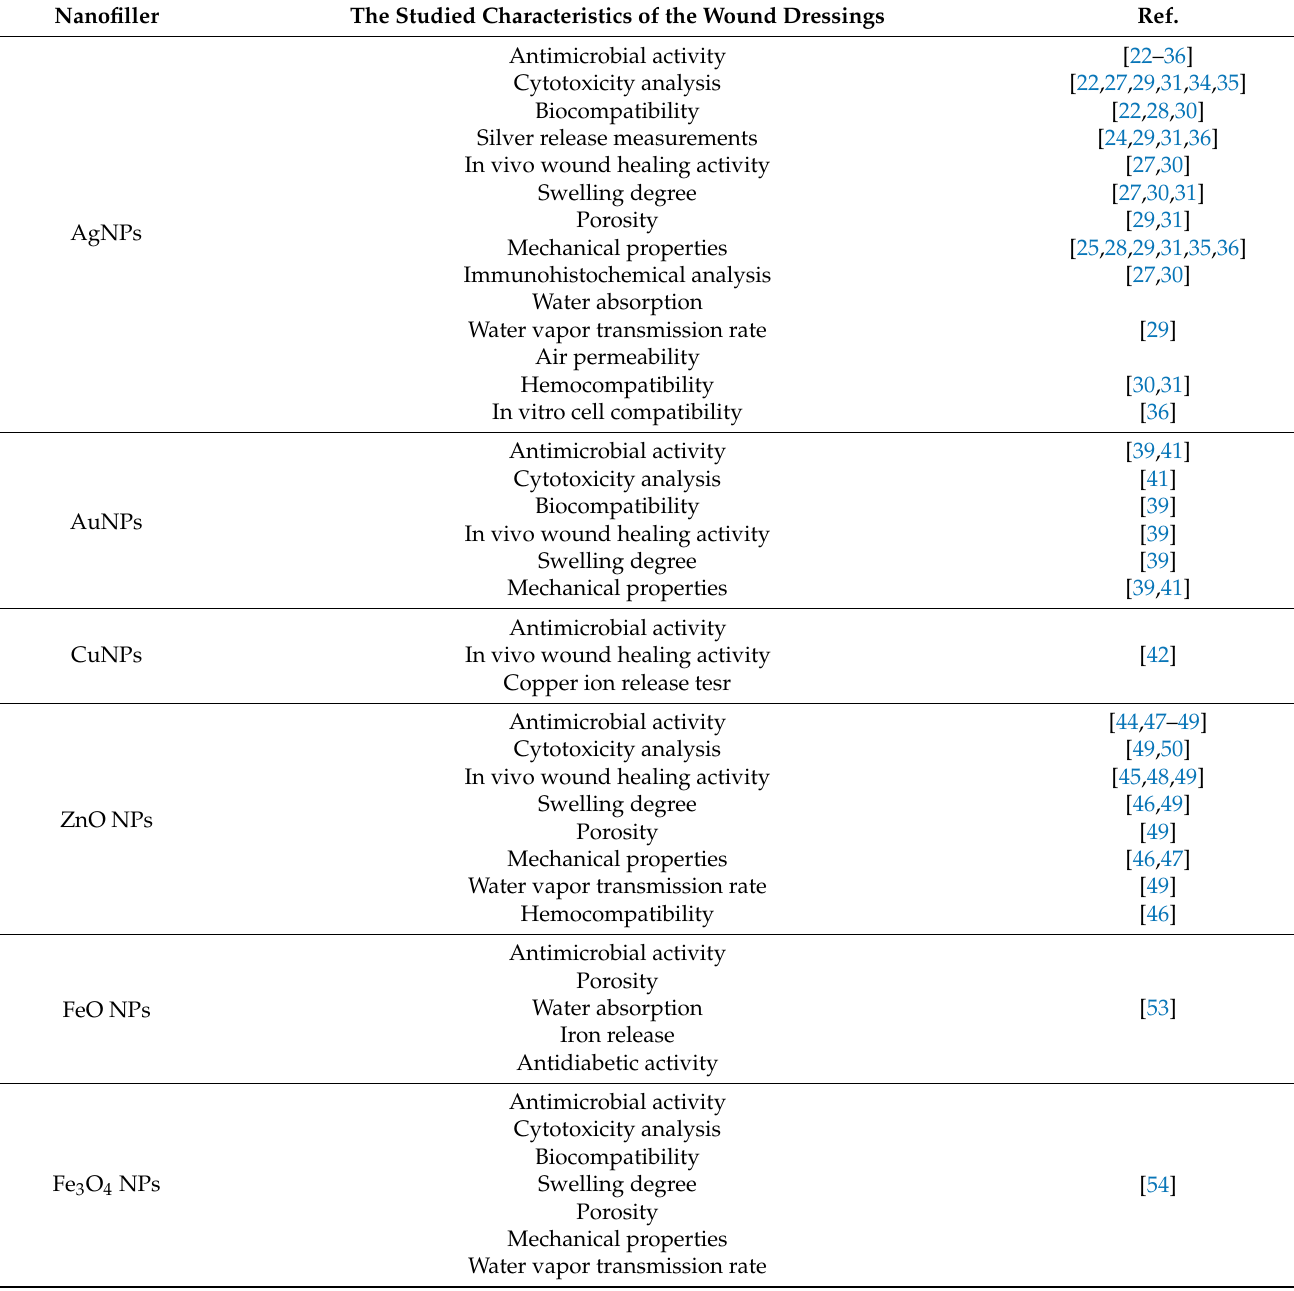
Table 3. The characteristics of the wound dressings studied in the presented publications. The Studied Characteristics of the Wound Dressings